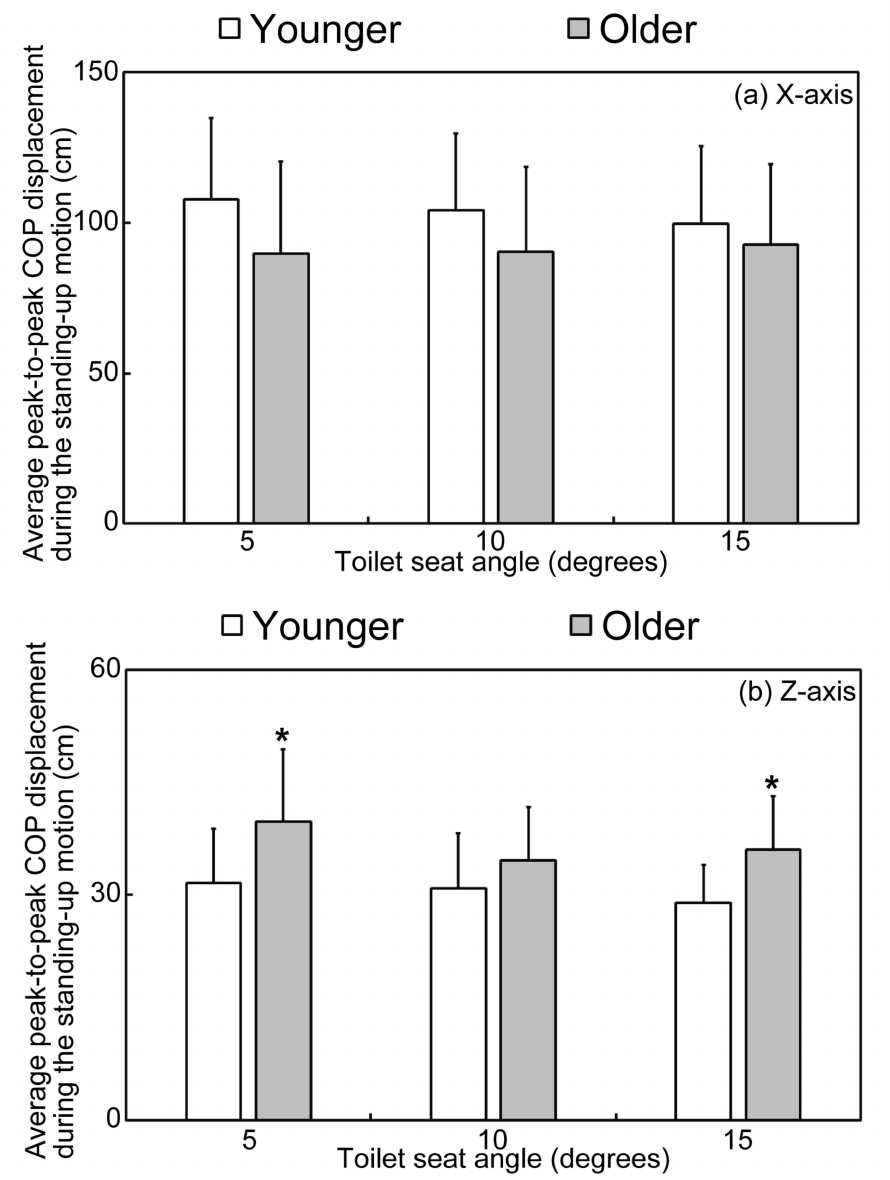
Figure 6. Peak-to-peak COP displacement in the X -axis ( a ) and Z -axis ( b ) according to toilet seat angle. Vertical lines denote the standard error of the mean. Asterisks indicate a statistically significant difference (based on the Bonferroni test) between younger and older participants. Bonferroni multiple comparison test (*) p <